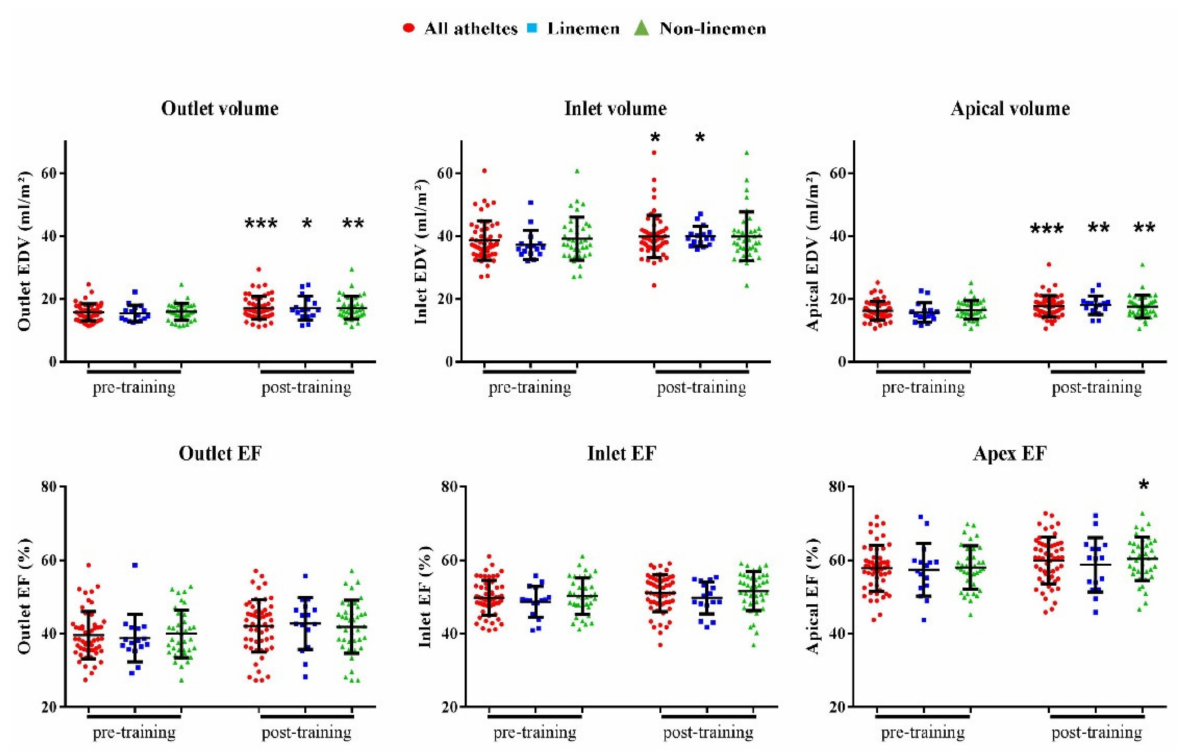
Figure 2. Longitudinal 3D RV regional morphological and functional changes. Abbreviations: EDV: end-diastolic volume, EF: ejection fraction. * p < 0.05, ** p < 0.01, *** p < 0.001 of a paired t -test comparing the variable before and after training. Table 3. Intra- and inter-observer reproducibility test for right ventricular (RV) global and regional 3D volumetric